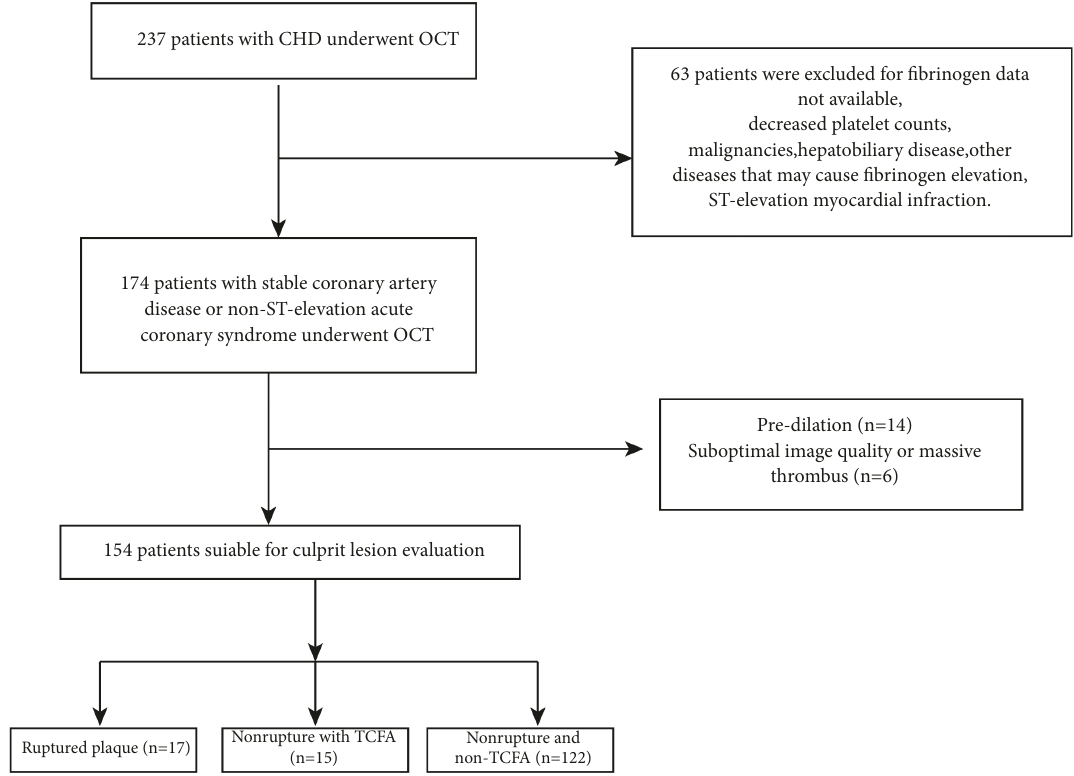
Figure 1: Flowchart of patient